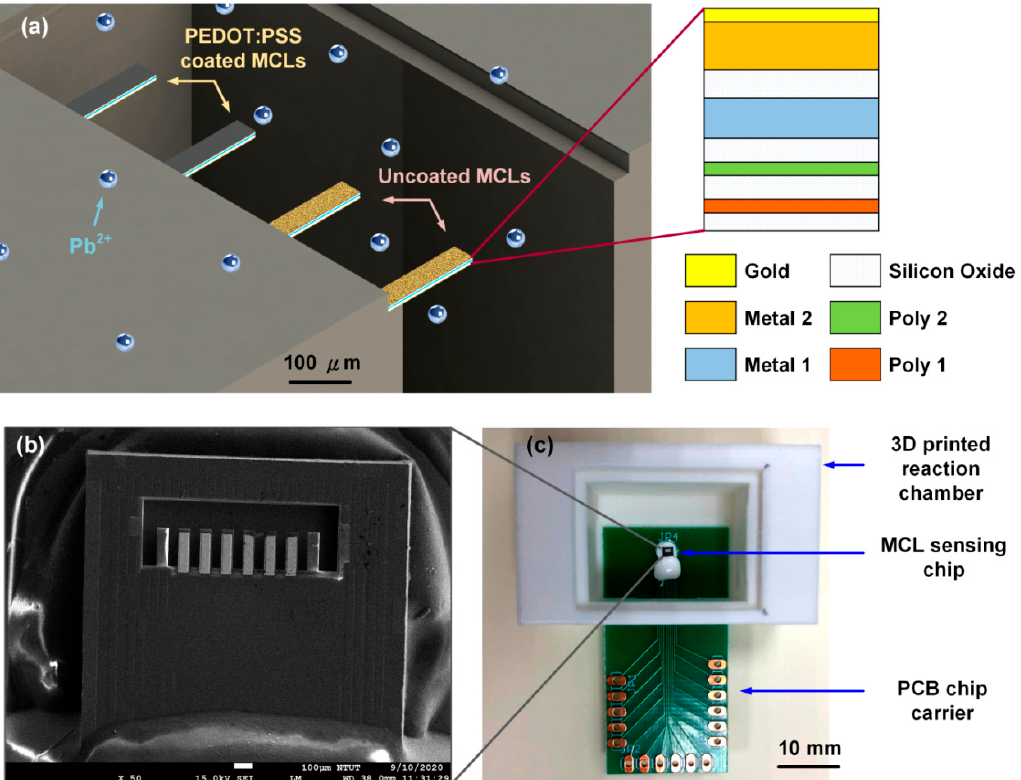
Figure 1. ( a ) schematic diagram of the detecting concept and multilayer structure of CMOS MEMS-based microcantilever sensing array; ( b ) the SEM photograph of the microcantilever sensing array chip wire bonded on the printed circuit board (PCB) chip carrier; and ( c ) the portable electric readout package of the microcantilever sensing array for Pb 2+ detection.